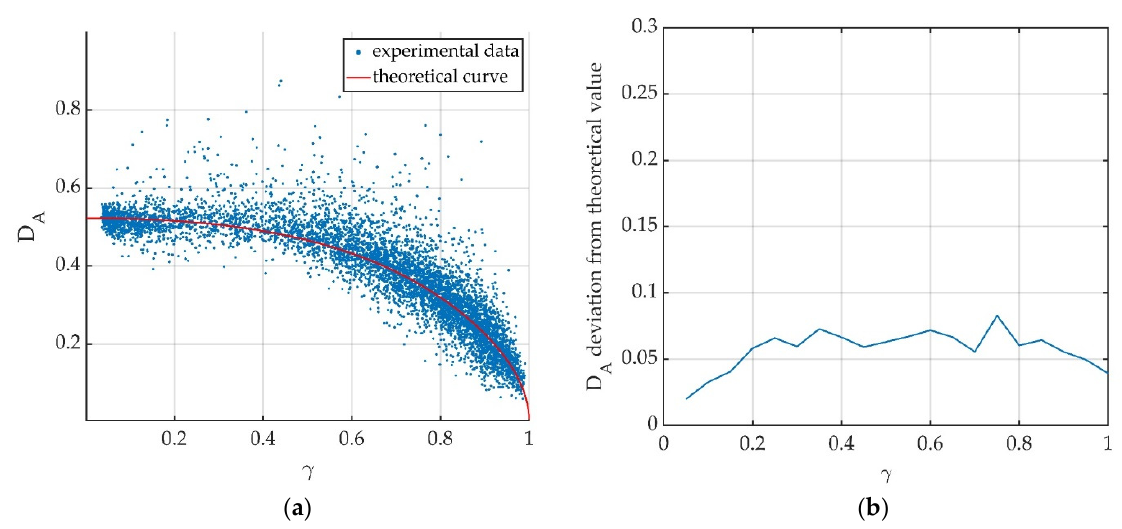
Figure 5. ( a ) Values of the amplitude dispersion index D A as function of the coherence γ , calculated for resolution cells of the investigated area, in Formigal. ( b ) Deviation of D (cid:2885) values from the theo- retical ones.